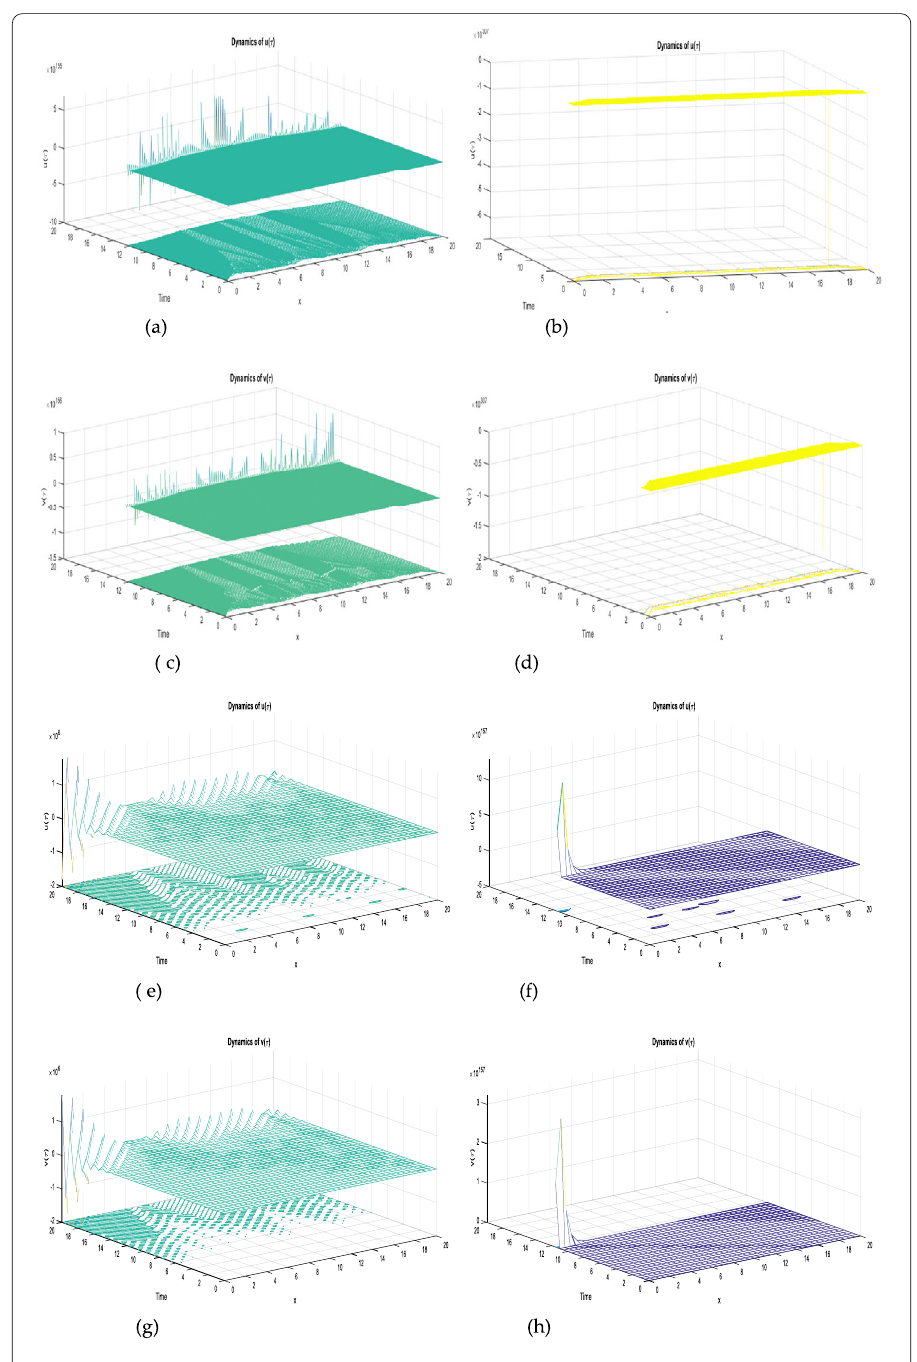
Figure 7 ( a )–( d ) Numerical solutions of systems (32) and (49) using Euler method. Here, u 0 = 1 + sin( x ) and v 0 = 2 + cos( x ), with l = 5, m = 1, κ 1 = 0.01, and κ 2 = 0.01. The plots of solutions v ( x , τ ) and u ( x , τ ) shows divergent behavior. ( e )–( h ) Numerical solutions of systems (32) and (49) using Crank–Nicolson method. Here, u 0 = 1 + sin( x ) and v 0 = 2 + cos( x ), with l = 5, m = 1, κ 1 = 0.01, and κ 2 =